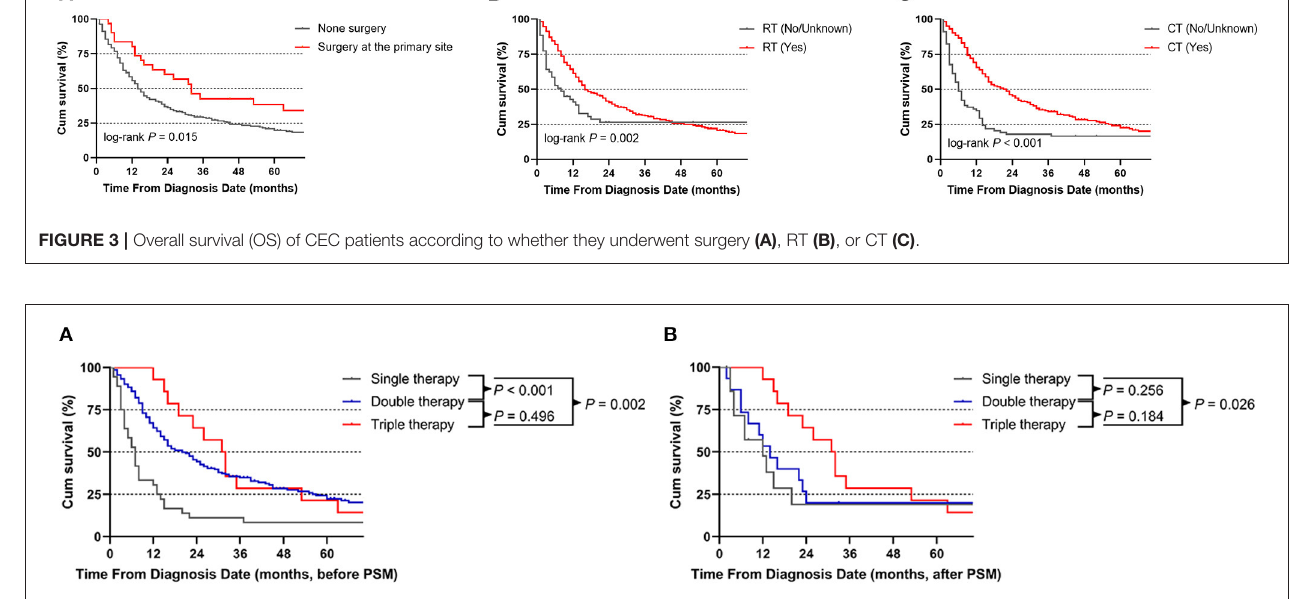
FIGURE 4 | Comparison of patients who underwent the three different treatment modalities before (A) and after (B) propensity score matching (PSM) analysis.